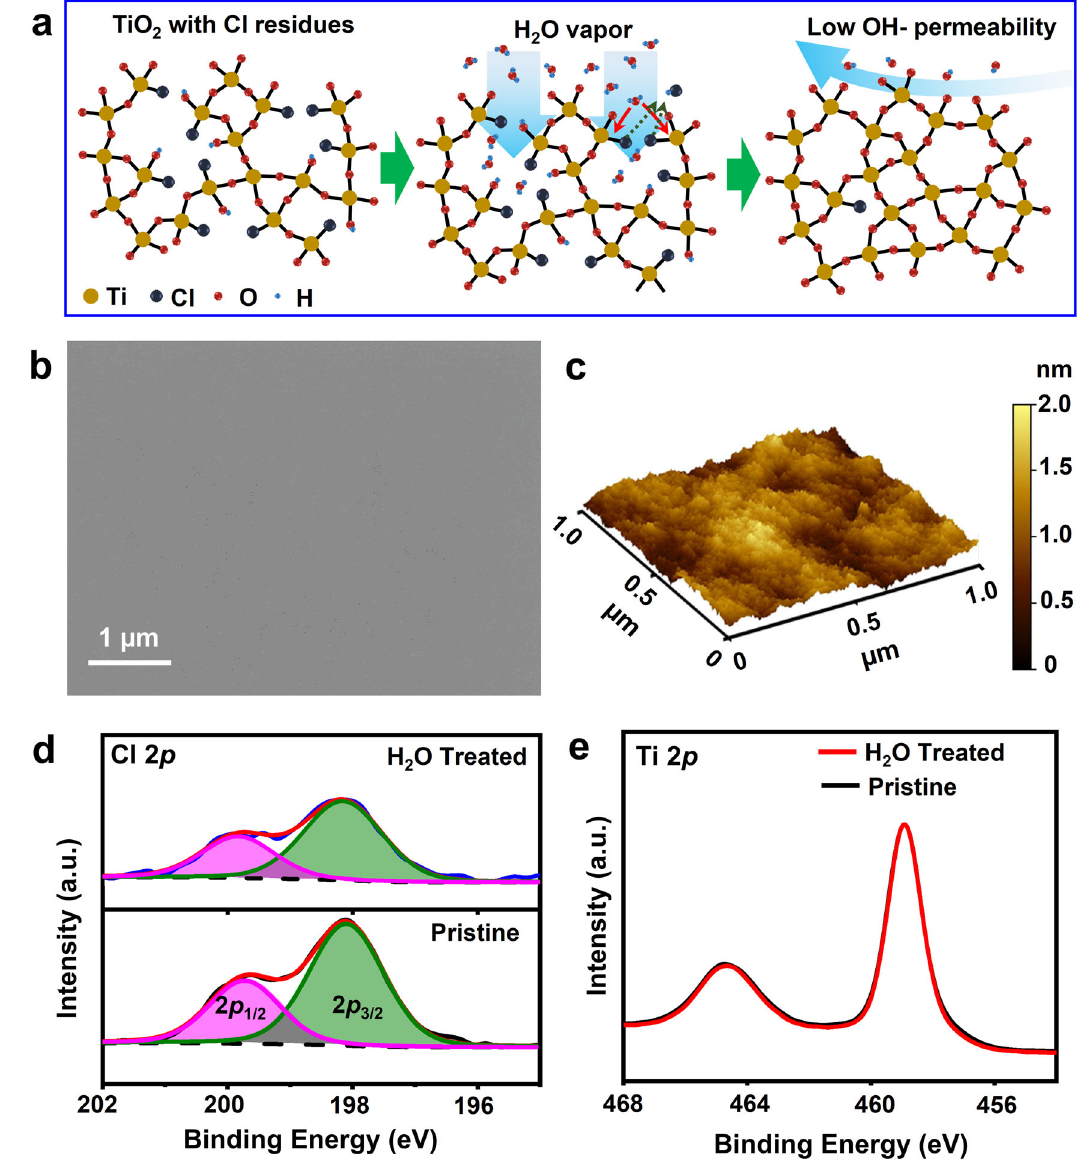
Fig. 3 | Water treatment of amorphous TiO 2 fi lms. a Schematics of water treat- mentshowingtheunreactedClligandsinamorphousTiO 2 (Left)beingremovedby reactingwithH 2 Omoleculesdiffusedthroughthe fi lmsurface(center)andforming a more continuous, interconnected Ti-O-Ti network. b SEM image of the amor- phous TiO 2 fi lm after being treated under pulsed water vapor exposure. c AFM